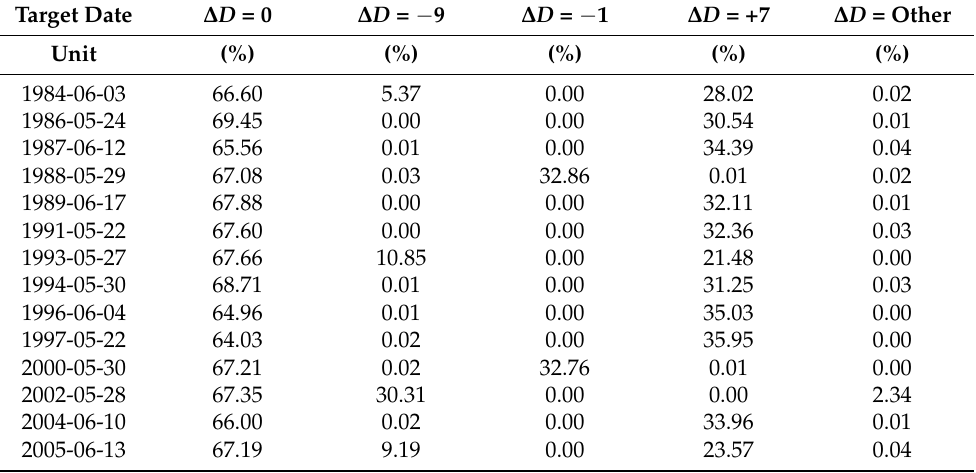
Table 2. Target dates used for Vegetation Dynamics 1.0 and pixel share of selected observations relative to the target dates ( ∆ D